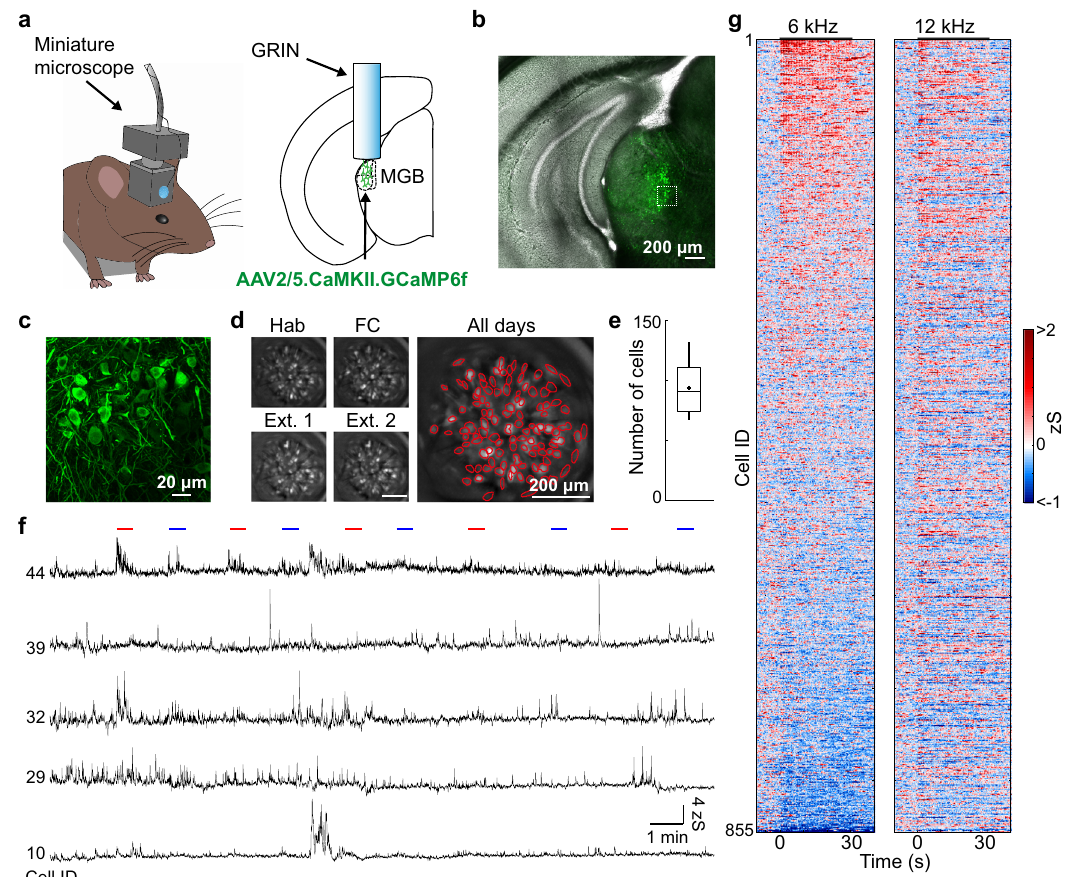
Fig. 1 Imaging neuronal activity of auditory thalamus in freely moving mice. a Mouse with a head-mounted miniaturized microscope (left). Location of gradient refractive index (GRIN) lens in the medial geniculate body (MGB, right). b Example GCaMP6f expression in MGB. Similarly replicated expression patterns for all animals where GCaMP6f was injected in MGB ( N = 24 mice). c High magni fi cation of GCaMP6f-expressing MGB neurons from B. d Individual motion corrected fi elds of view (maximum intensity projection) of one example animal across a four-day fear conditioning paradigm (Hab, FC, Ext. 1, Ext. 2) as well as the maximum intensity projection across all days. Red circles indicate selected individual components. Replicated for all mice ( N = 24) that underwent calcium imaging. e Average number of individual ICs/animal (93 ± 4 neurons, N = 24 mice). Boxplots show median, 2 nd , 3 rd quartile, minimum and maximum. Cross indicates mean. f Changes in Ca 2 + fl uorescence of fi ve individual neurons during the habituation session. Lines